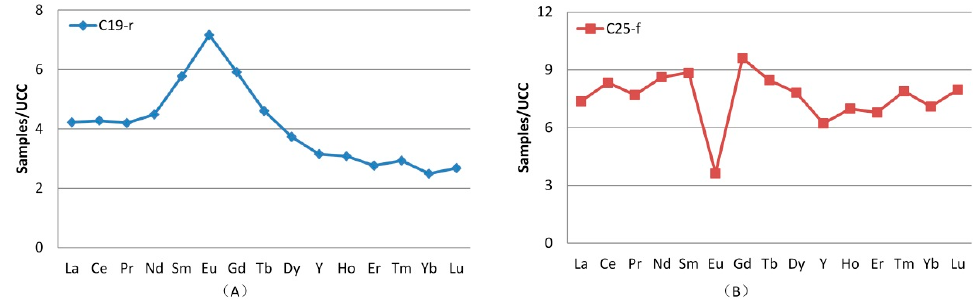
Figure 15. Distribution patterns of REE in the roof and floor samples from the Shiping mine. REE are normalized by Upper Continental Crust (UCC) [32]. ( A ) Distribution patterns of REE in sample C19-r; ( B ) Distribution patterns of REE in sample C25-f.